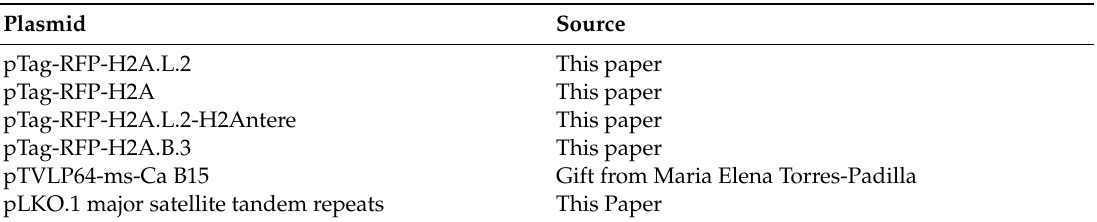
Table 1. Recombinant